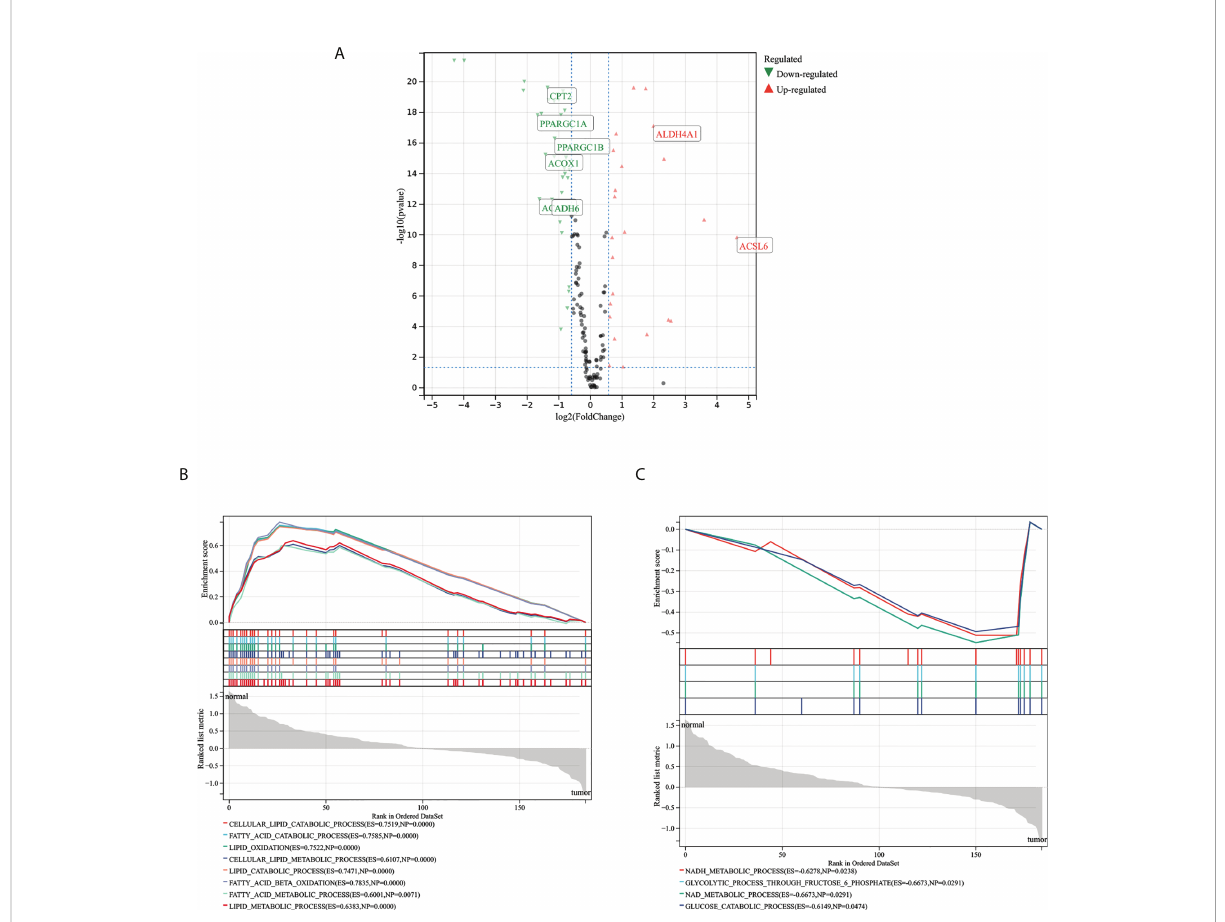
FIGURE 1 Expression and biological processes of the MMRG gene. (A) Volcanic map of MMRG gene expression in COAD; green represents downregulation in tumors, red represents upregulation in tumors. (B, C) The biological processes of MMRG, which were activated in normal tissue on the left and tumor tissue on the right. MMRGs, mitochondrial energy metabolism pathway-related genes; COAD, colon